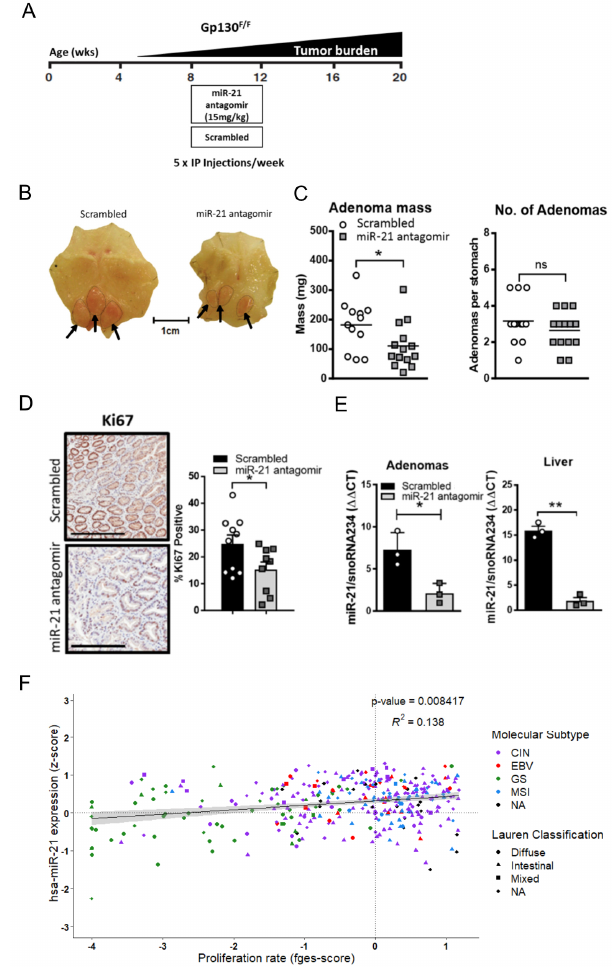
Figure 4. Pharmacological inhibition of miR-21 in vivo attenuates gastric adenoma growth. ( A ) Schematic of the treatment schedule of Gp130 F/F mice. ( B ) Representative whole mounts of stomachs collected after the end of a 4-week treatment period with the scrambled of miR-21 antagomir that was commenced in 8-week old Gp130 F/F mice on a C57Bl/6 × 129Sv background. The stomachs were opened along the outer curvature. The arrows indicate adenomas in the glandular part. ( C ) Enumeration of the total tumor mass and individual adenomas per Gp130 F/F mouse treated as described in ( B ). ( D ) Ki67 immuno-histochemical staining of cross-sections of the adenomas from Gp130 F/F mice treated as described in ( B ). The quantification of the Ki67 stains was carried out with ImageScope analysis software. ( E ) Q-RT-PCR TaqMan analysis of the miR-21 expression in the adenomas and livers of Gp130 F/F mice treated as described in ( B ) and normalized against the expres- sion of the housekeeping gene SnoRNA234. ( F ) Correlation analysis of miR-21 (z-score) with the “proliferation” functional gene signature (fges) using the TCGA STAD dataset. Each dot represents a single cancer, indicating both its molecular subtype and Lauren classification. Each symbol represents a data point from an individual mouse, and the data are depicted as the mean ± SEM. * p < 0.05; ** p < 0.01; n.s., not significant. Scale bar = 200 µ